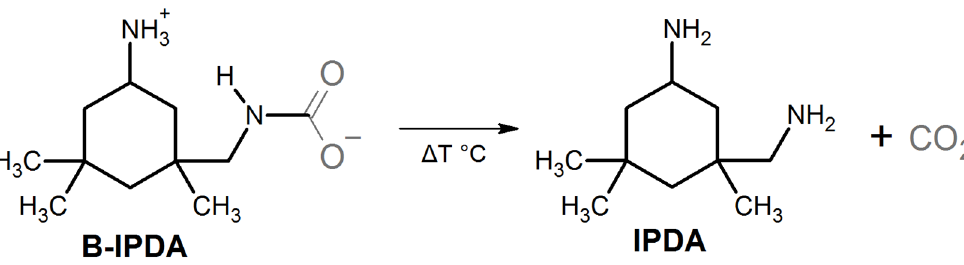
Figure 1. Decomposition reaction of isophorone diamine carbamate (B-IPDA) releasing the IPDA curing agent and CO 2 blowing agent.